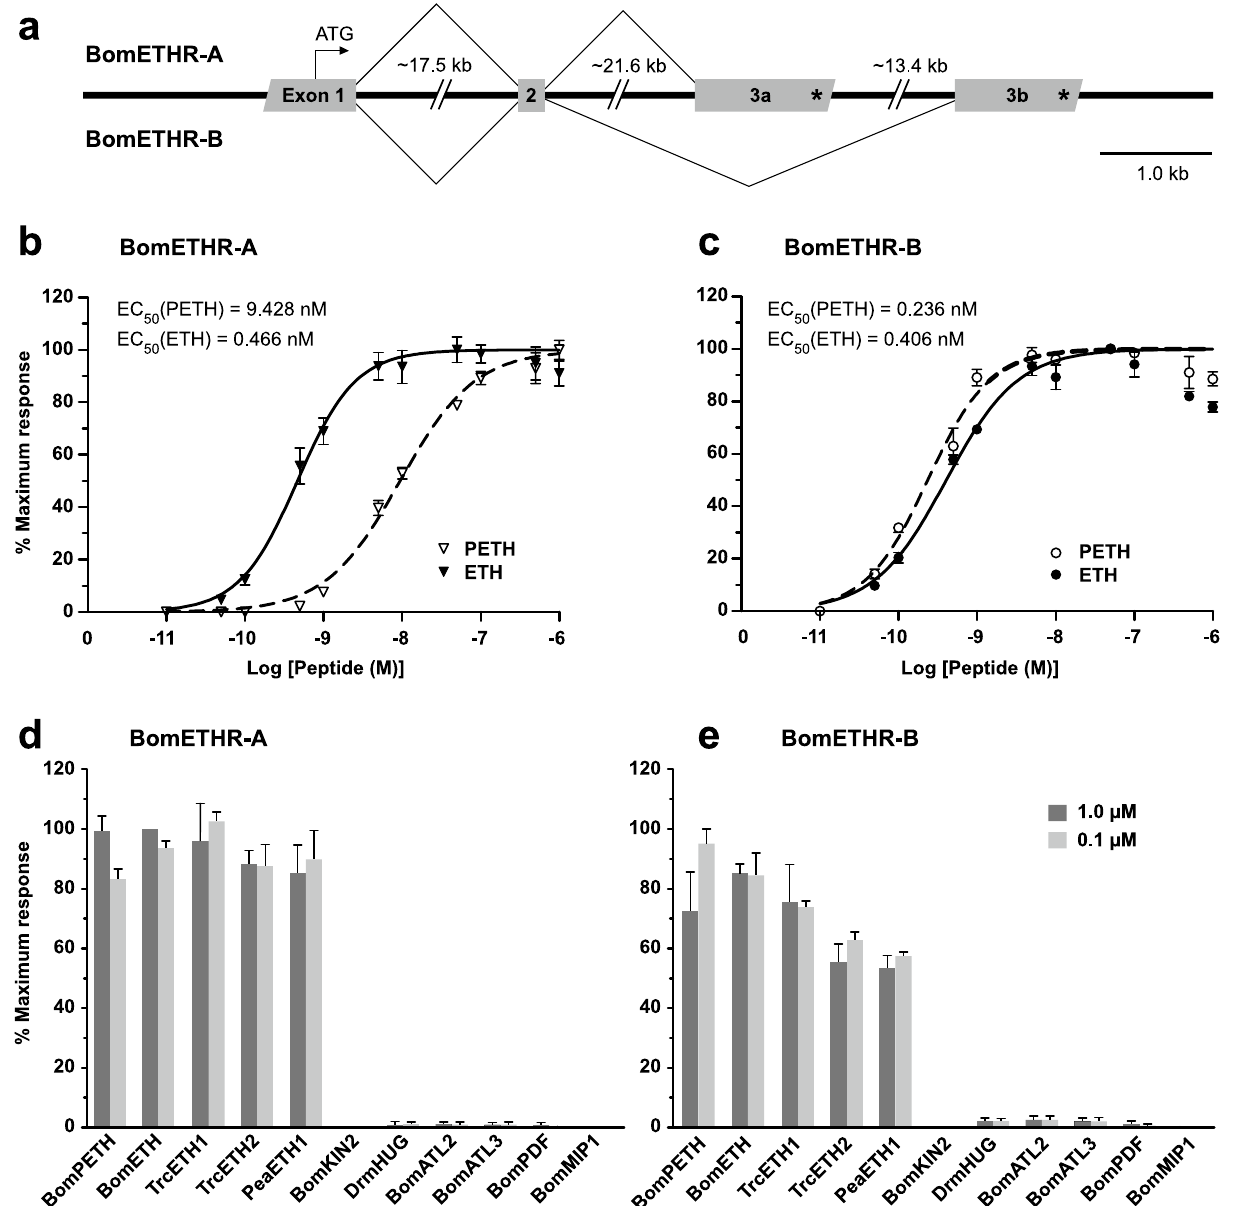
Figure 1. Genomic structure and characterization of ETHRs. ( a ) Schematic representation of ethr gene structure in B. mori. The receptor has two alternative transcripts with mutually alternative exons 3a and 3b. Exons and introns are indicated by grey boxes and solid lines, respectively. The stop codon is indicated by a star (*). ( b , c ) Dose–response curves for ETHR-A and ETHR-B heterologously expressed in CHO cells following application of different concentrations of PETH and ETH. Each response is expressed as a percentage of maximum peak luminescence induced by the respective ligand. Each data point is a mean value ± SE (n = 3). Insets show EC 50 values for each ligand. ( d , e ) Luminescence produced by CHO cells expressing ETHR-A and ETHR-B after application of additional peptide ligands (0, 1 μM and 1 μM), normalized against the response to 1 μM ETH ( d ) and 0,1 μM PETH ( e ) respectively. Synthetic peptides used in the assay are listed in Supplementary Table S2 online. Bom, Bombyx mori ; Trc, Tribolium castaneum ; Pea , Periplaneta Americana ; Drm, Drosophila melanogaster